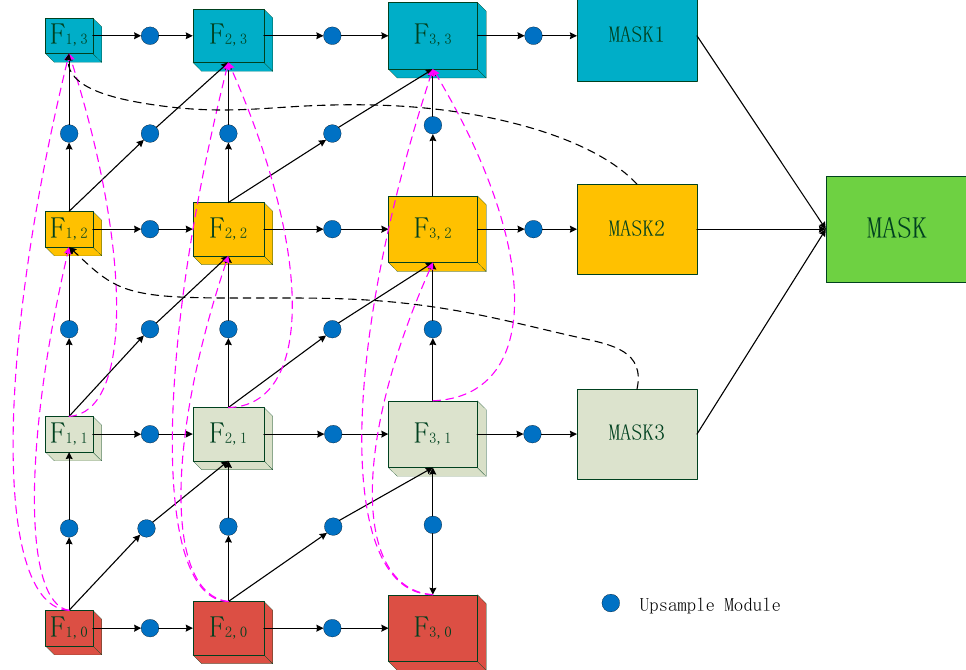
Figure 4. The structure of cross-stage and cross-resolution feature fusion refinement pathway.